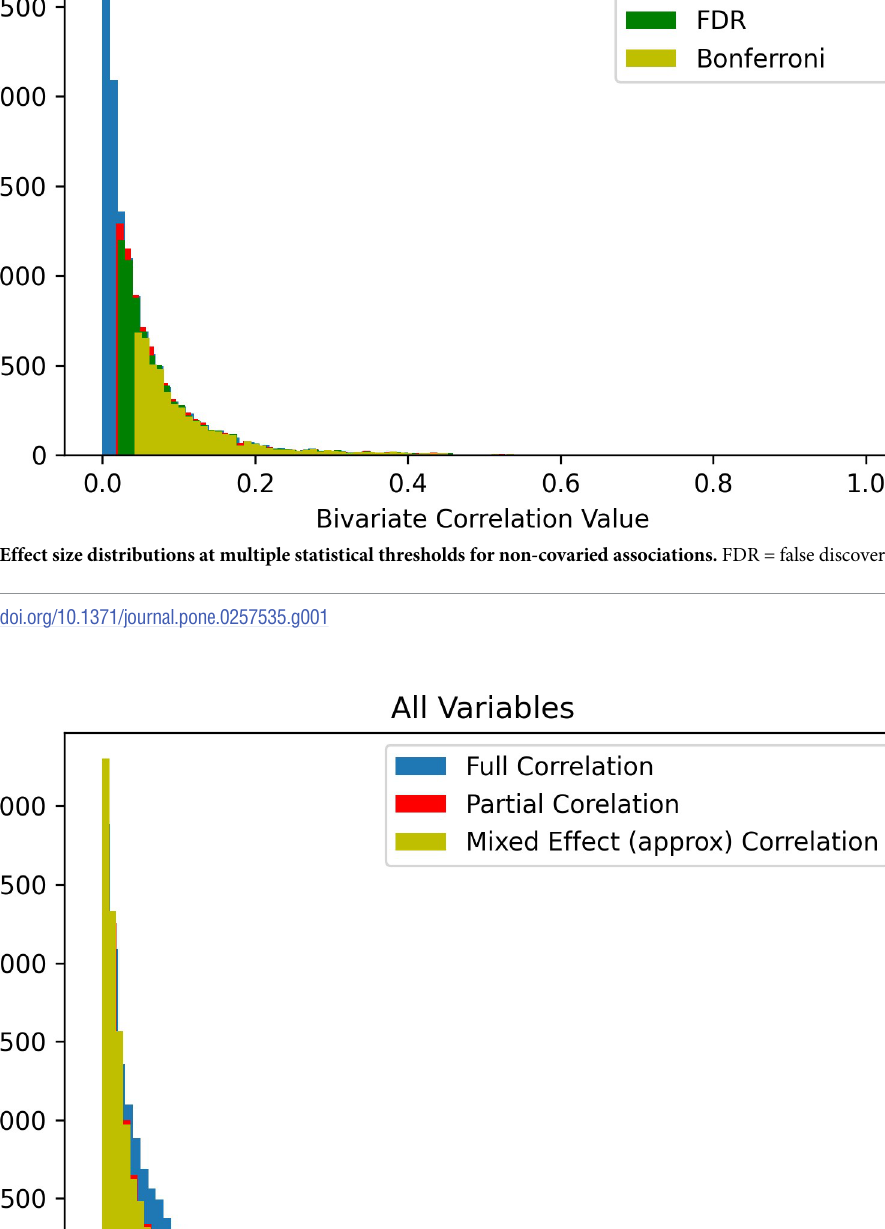
PLOS ONE | https://doi.org/10.1371/journal.pone.0257535 September 23,